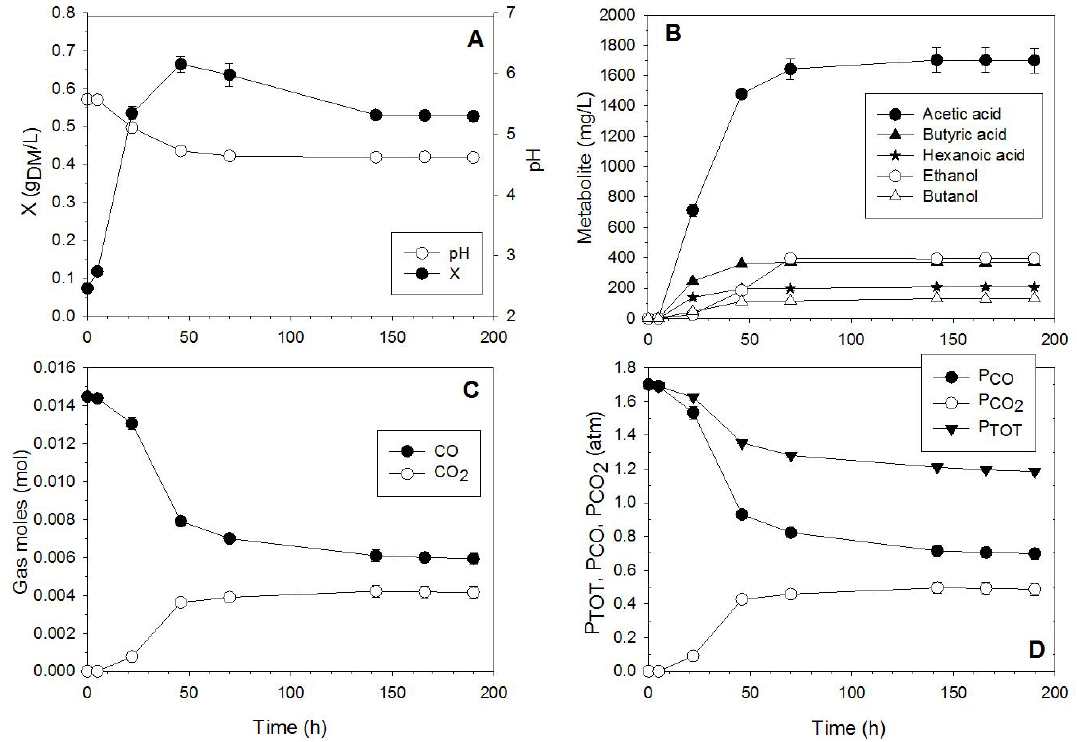
Figure 1. Data vs. time measured during a batch fermentation—initial P CO = 1.7 atm; V L /V G = 0.28. ( A ) Cell concentration and pH; ( B ) metabolite concentration; ( C ) CO/CO 2 moles temporal profiles in the